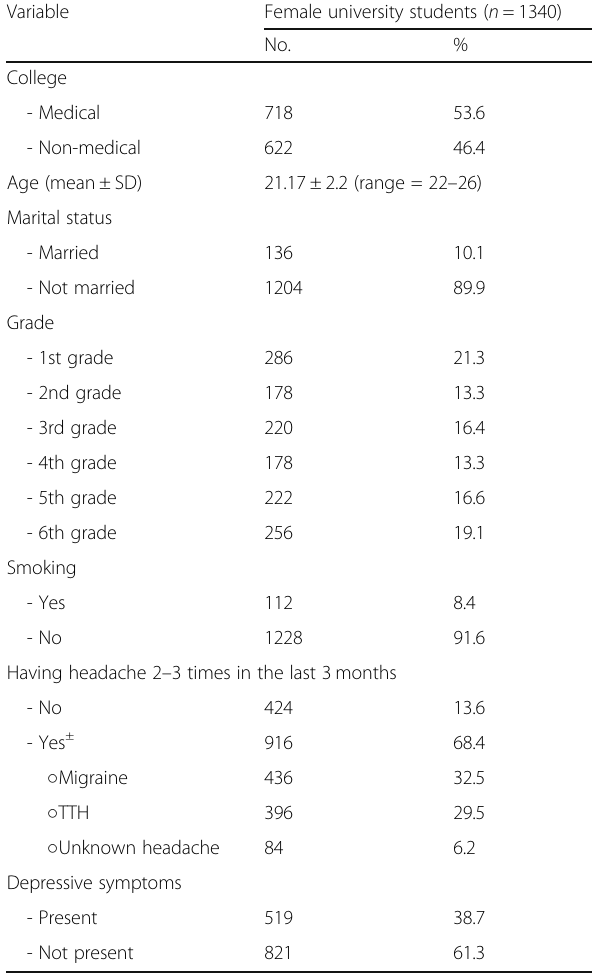
Table 1 Distribution of the studied female university